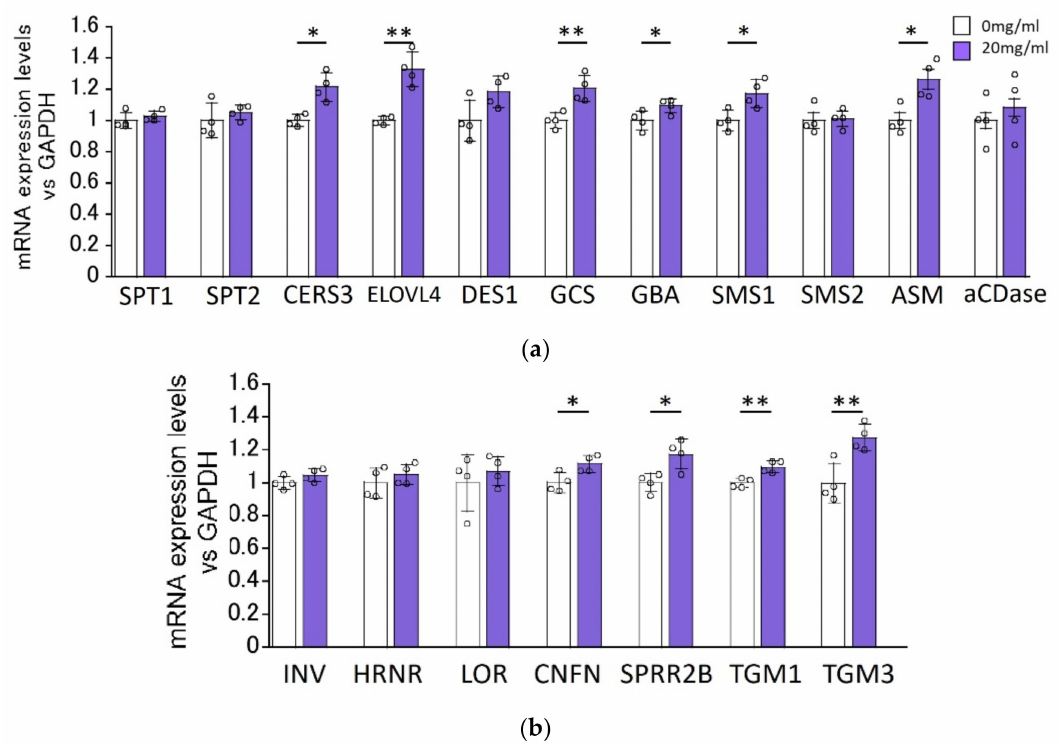
Figure 3. Effect of HC on the expression of ceramide synthesis- ( a ) and keratinization-related ( b ) genes in RHEEs. RHEEs were treated daily with HC (at 0 and 20 mg/mL) for 2 days and total RNA was extracted as described in the Section 4 Materials and Methods. mRNA expression levels were determined by real-time RT-PCR and are expressed as each mRNA level/glyceraldehyde-3- phosphate dehydrogenase (GAPDH). Bars represent mean ± SD, n = 3, Student’s t -test. *: p < 0.05, **: p <